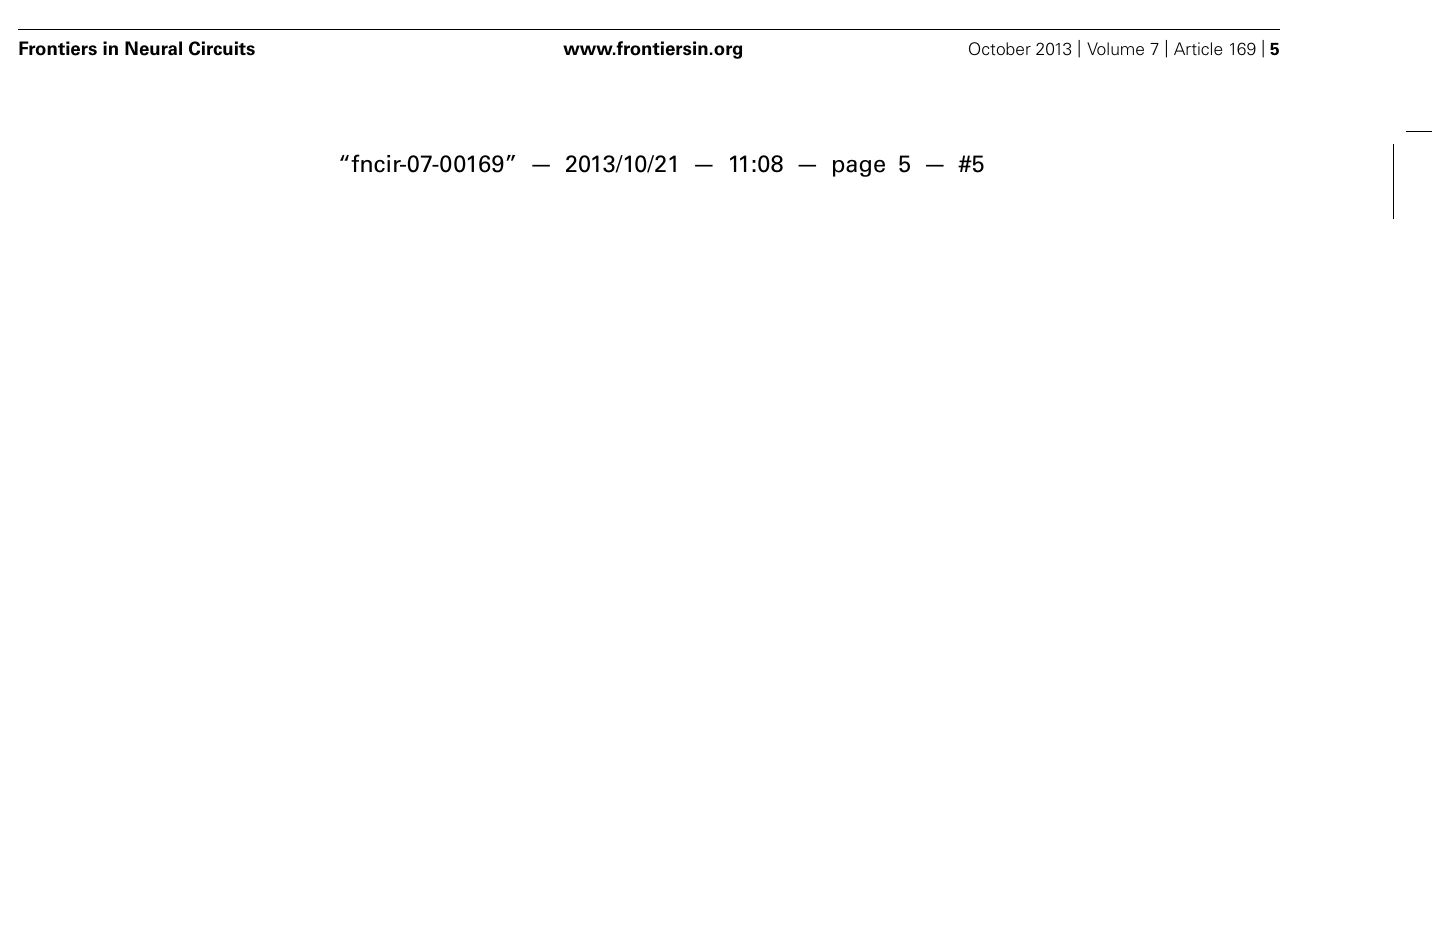
FIGURE 3 | LP I h activity-dependence curve in 5 μ M DA. (A) Experimental protocol: TEVC was used to create a recurring voltage step that mimicked slow wave activity at t = − 10 min, except the length of the depolarizing step varied across experiments to alter burst duration. Examples are shown for how the length of the step corresponded to no change, a reduction or an increase in burst duration. There was no